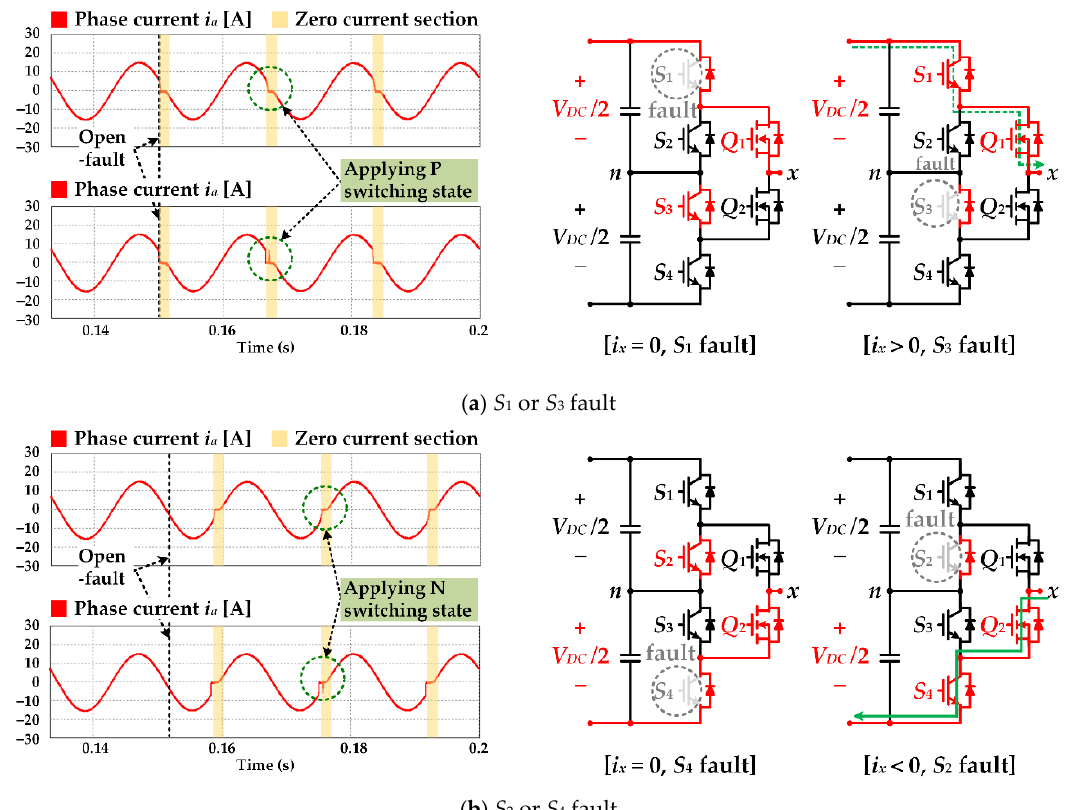
Figure 10. Process to identify a faulty location in two Si IGBT candidates switches by using P or N switching state.